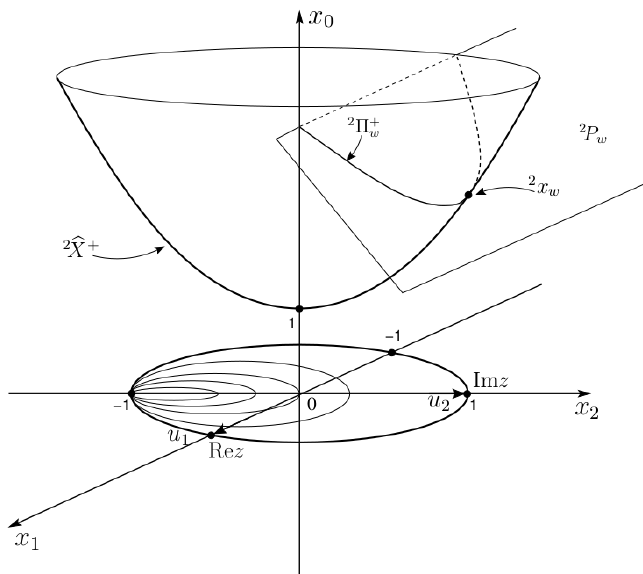
Figure 4. Upper sheet 2 X + of the real two-sheteed hyperboloid. Re z is directed along u 1 and Im z along u 2 2